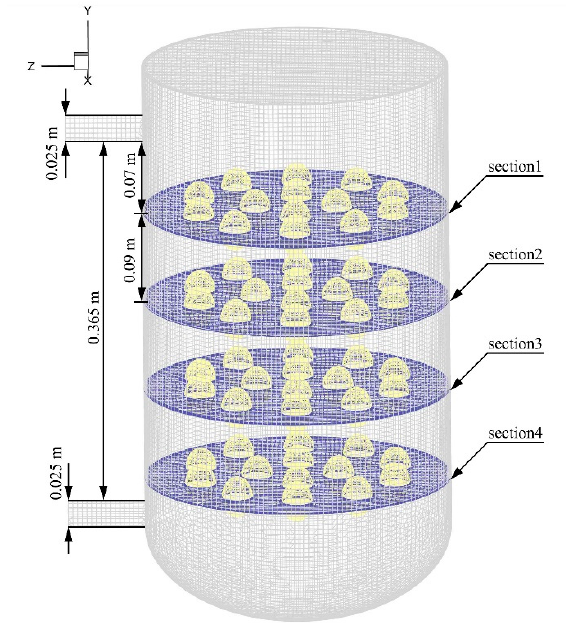
Figure 1. Location of the selected four